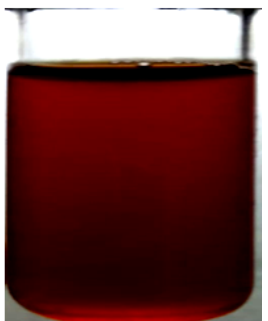
Fig. 4. Banana Leaves extract -silver nanoparticles (BL-AgNps) obtained by microwave assisted biosynthesis